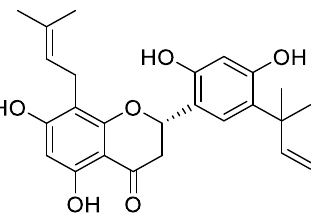
Figure 11. Chemical structure of 2′,4′-dihydroxy-5′-(1′′′,1′′′-dimethylallyl)-8-prenyl pinocembrin (8PP).